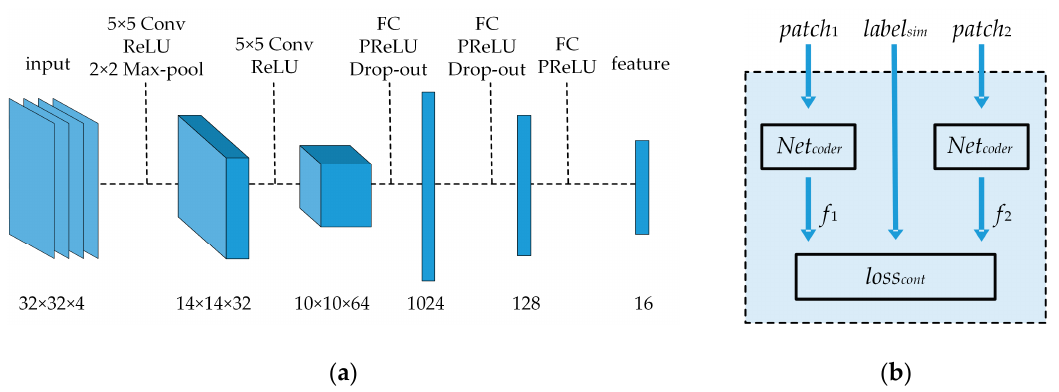
Figure 5. ( a ) Architecture of the feature-encoding network; ( b ) architecture of the Siamese network.